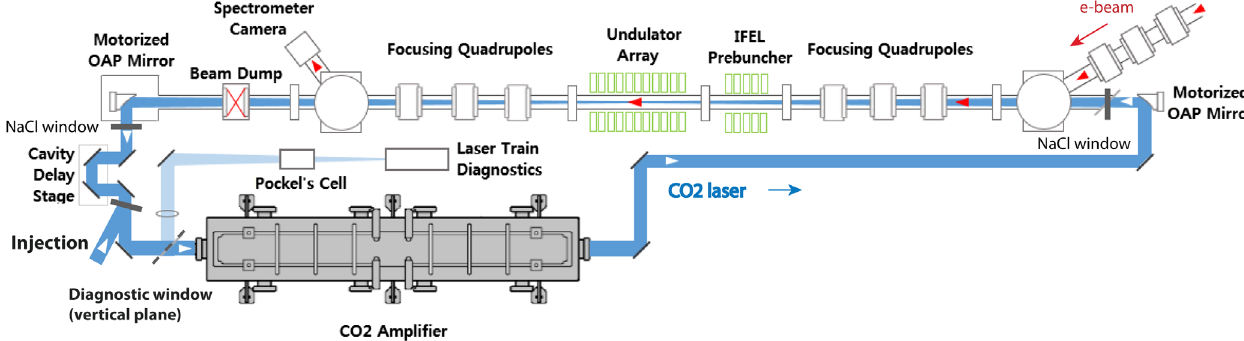
FIG. 1. Layout of high repetition rate IFEL experiment. A 50 MeV beam is injected into the ATF beamline 2 via dipole (on the right- hand side), focused in the matching section into the prebuncher and redirected into IFEL helical undulator. A laser beam is injected into the CO 2 optical active cavity where it is amplified and introduced into the electron beamline just upstream of the dipole to co-propagate with the electron beam. An accelerated e-beam is refocused onto the magnetic spectrometer diagnostic screen and disposed, whereas the laser beam is recirculated and reamplified to interact with the subsequent bunch within the electron beam pulse train. The laser cavity length is set to approximately 14.7 m (49 ns), and an optical delay stage is introduced to achieve beam-laser synchronization throughout the duration of the pulse train.